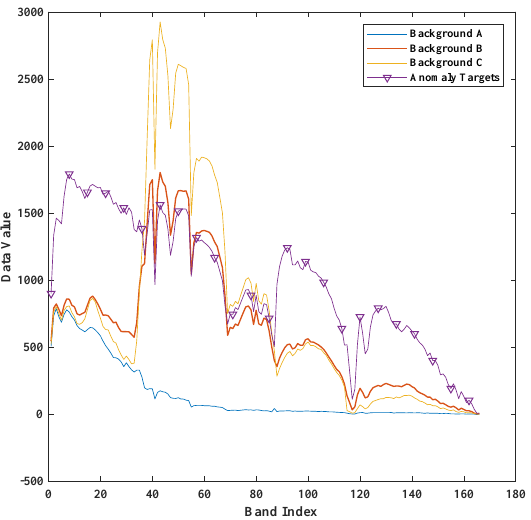
Figure 4. The spectral signature of anomaly targets and different background pixels in Lake Salvador dataset.